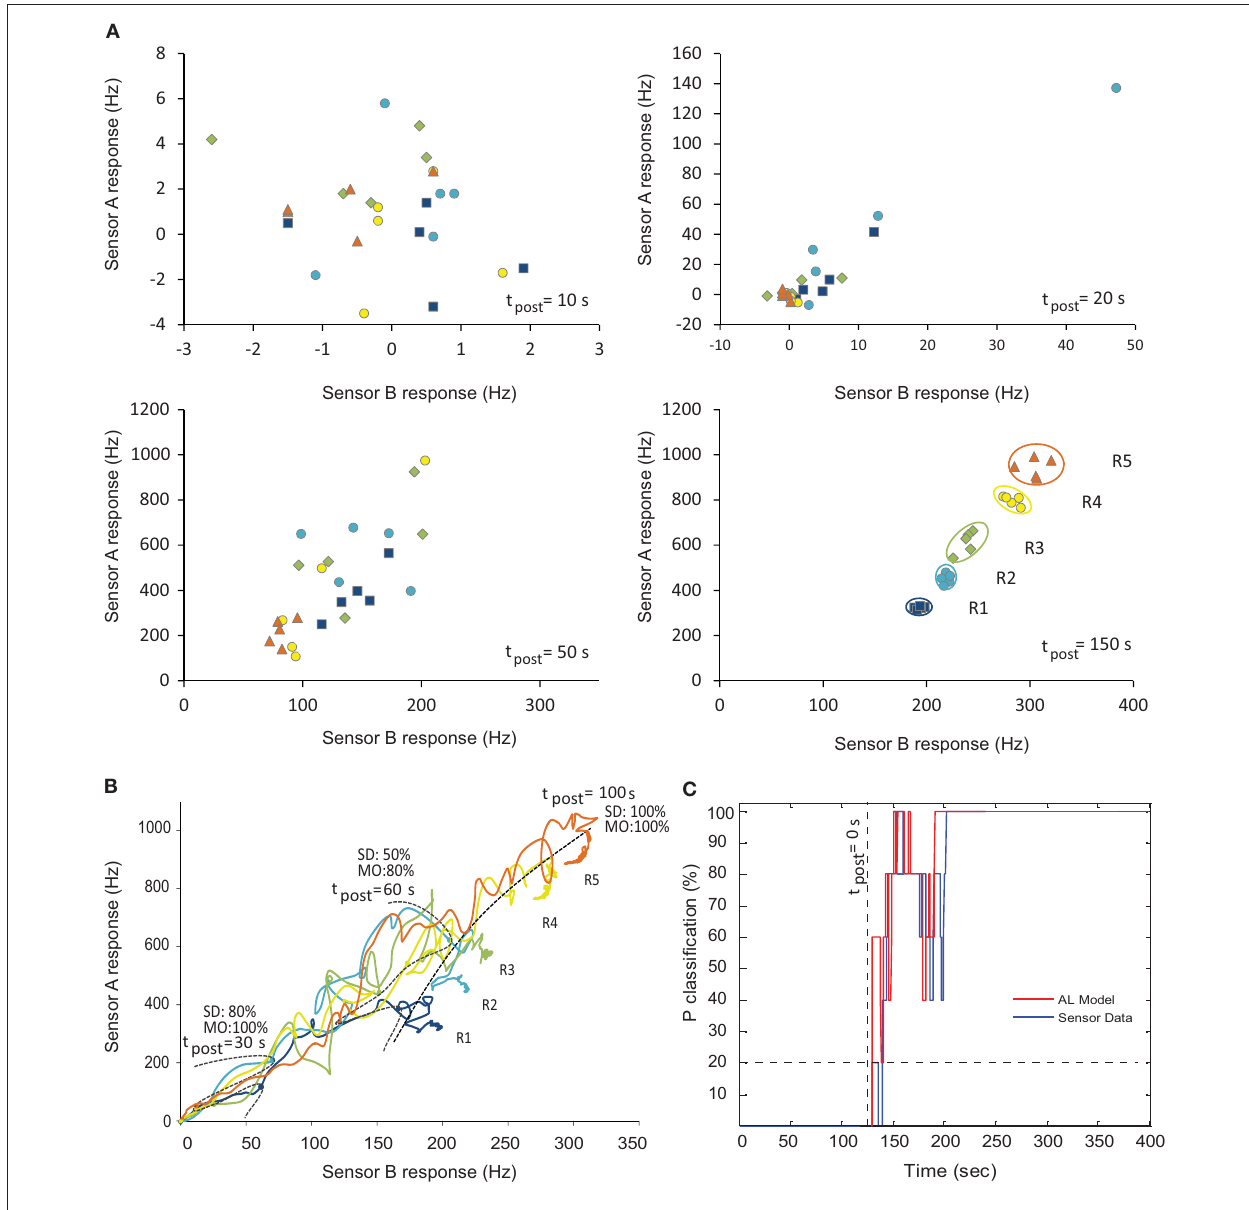
FIGURE 6 | Ratiometric classification performance of the neuromorphic MGC AL model over time. (A) SAWR input chemosensor pair responses for different chemical ratios (see Table 1 ) at different points in time of the transient response post stimulus. (B) SAWR chemosensor pair raw data trajectories showing the difficulty of separation according to ratio during the transient phase (before 100s post-stimulus). Time frontiers are shown at 30, 60, and 100s post-stimulus, together with the classification probability ( P classification ) for